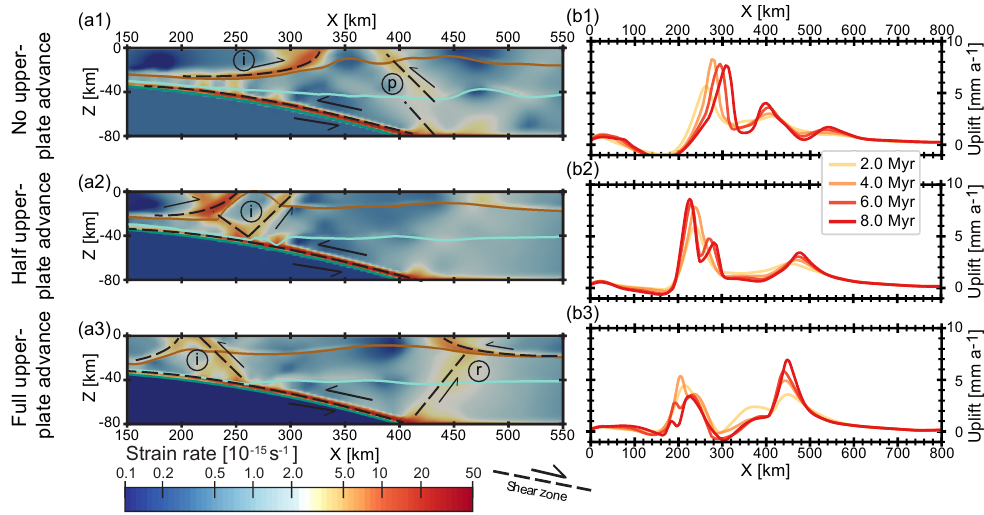
Figure 5. Temporal evolution of the no-, half-, and full-uadvance indenter geometry models (4–6). (a) Strain rates on the y = 400km cross section at 8Myr modeling time (cf. Fig. 4 showing same slices at 4Myr). (b) Time slices of surface rock uplift rates along y = 400km. No- upper-plate advance (model 3; a1, b1 ) scenario shows an indenter detachment in dynamic steady state, which slowly migrates to the right. In the half-advance scenario (model 4; a2, b2 ), uplift above the indenter likewise saturates, but its position is stable, and additional shear zones form in the last stage. Lastly, the full-advance case (model 6; a3, b3 ) exhibits most uplift at the right uplift band, which continuously increases, whereas the indenter uplift ceases again after reaching a peak at 4Myr simulation